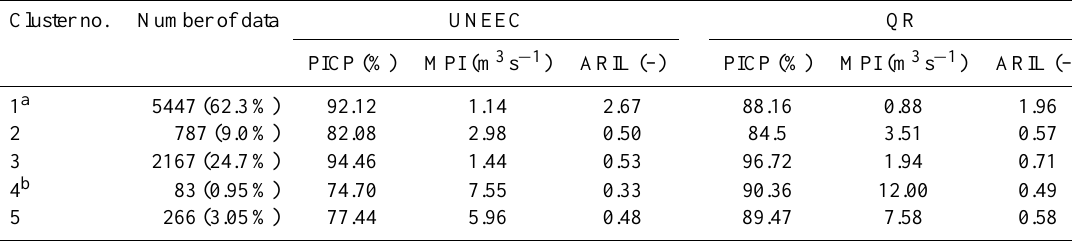
Table 3. PICP, MPI, and ARIL values for each cluster (training, 90% confidence level, Brue): UNEEC vs. QR. Cluster